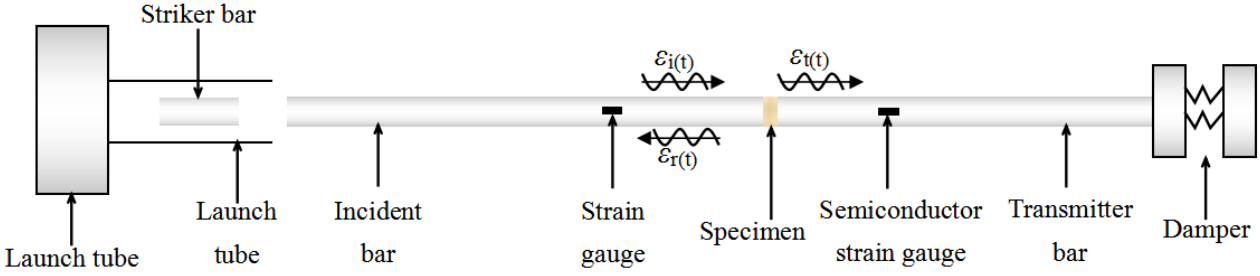
Figure 2. Test device schematic diagram.